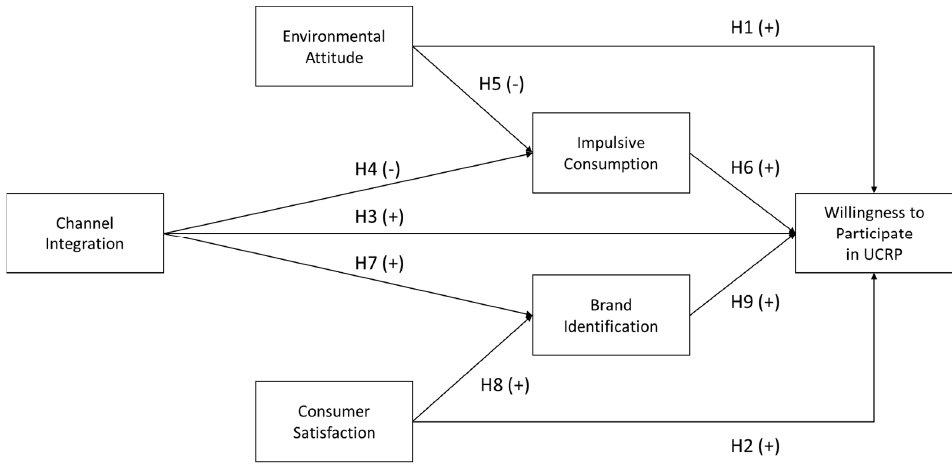
Figure 1. Structural Model.